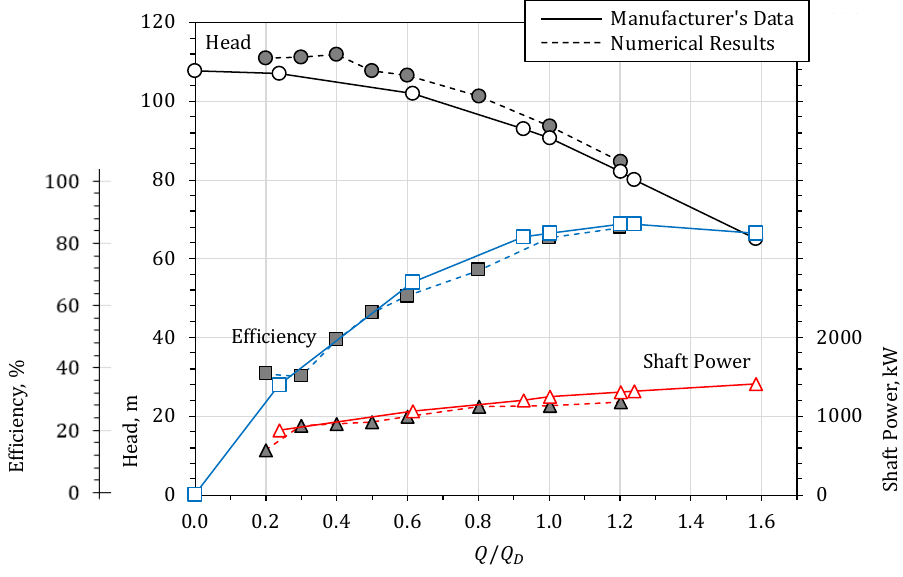
Figure 8. Pump Performance Curve based on CFD calculations and Manufacturer ’ s data.